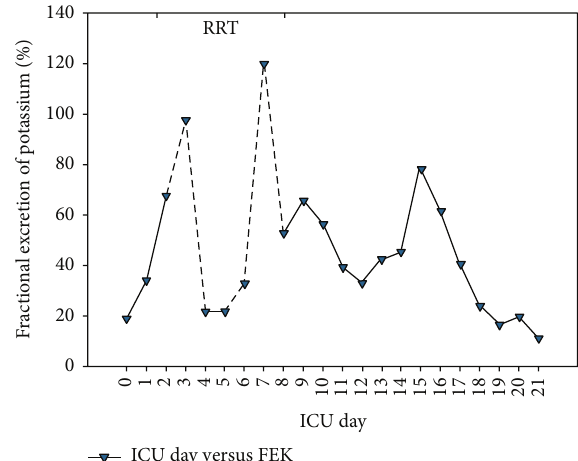
Figure 4: Fractional excretion of potassium (FEK) in the course of hemorrhagic shock and subsequent septic shock. Dashed lines represent the period in which FEK is unreliable due to renal replacement therapy (RRT). ICU: intensive care